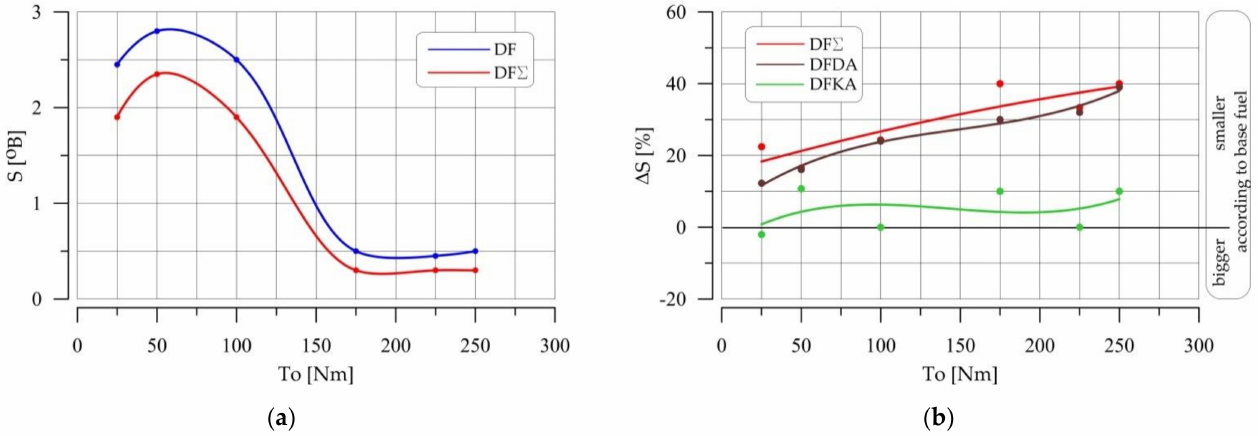
Figure 15. ( a ) The smokiness of exhaust fumes vs. engine torque; ( b ) Percentage difference in exhaust fumes smokiness vs. engine torque in relation to the base